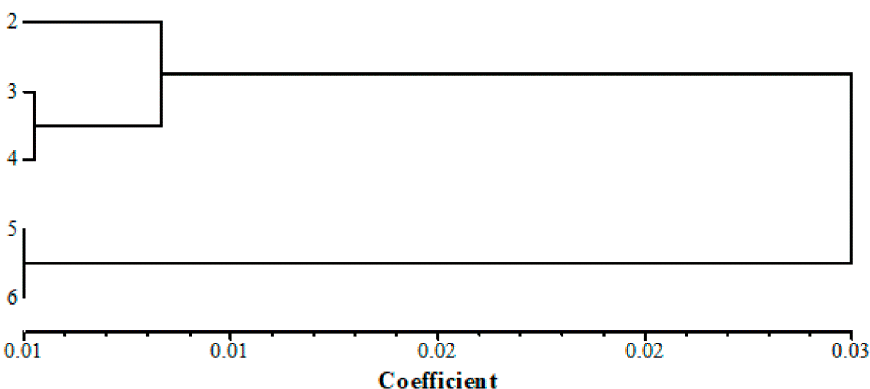
Figure 4. Unweighted pair-group method of arithmetic averages (UPGMA) dendrogram generated EST-SSR data showing relationships of bermudagrass groups with di ff erent ploidy level. Numbers (2–6) from EST-SSR data showing relationships of bermudagrass groups with different ploidy level. correspond to ploidy Numbers (2–6) correspond to ploidy levels.